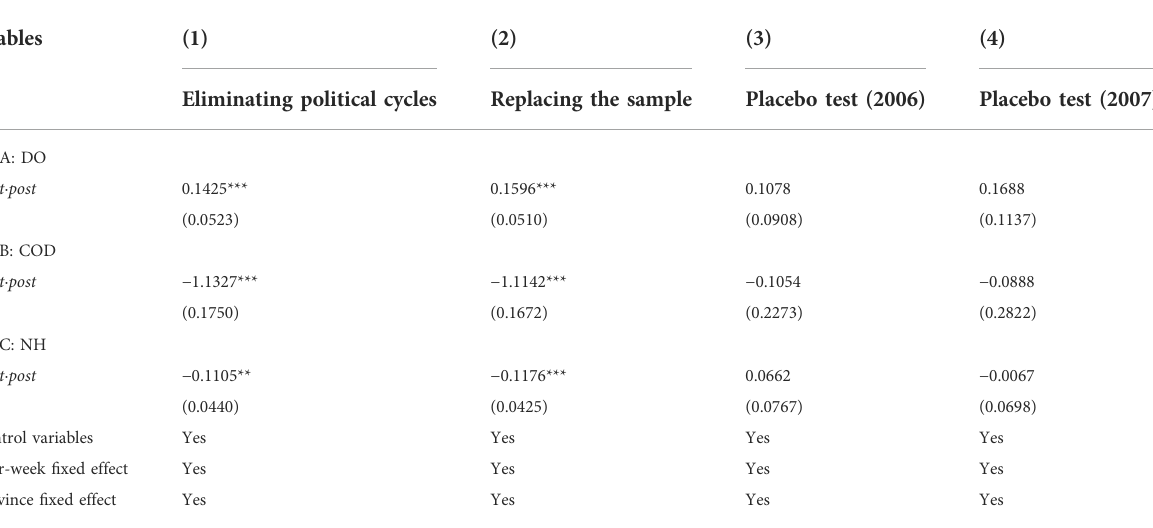
TABLE 4 Robustness test